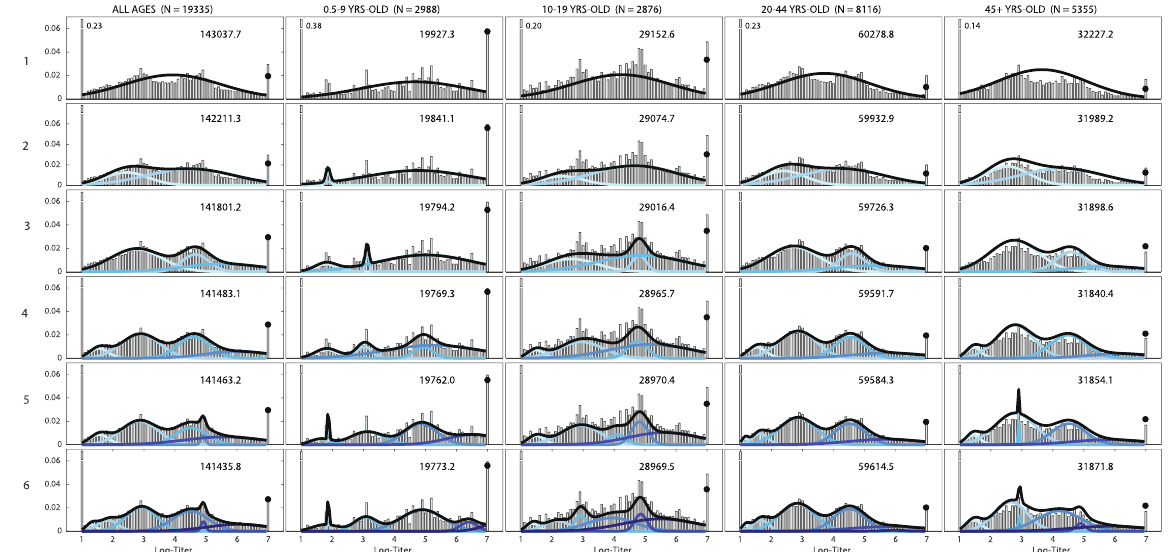
Figure 4. Titer histograms and fit results for mixture models with different numbers of components (label on the left is the number of mixture components) and grouped by different age groups recommended by the CONCISE (http://consise.tghn.org/) consortium for 2009 H1N1 influenza. Histograms are weighted to adjust for age and gender according to the Vietnam national housing census in 2009. The numbers in the upper right corner of each panel are the fitted BIC scores of the respective model. For each panel, the blue lines are the normalized probability density of the component distributions with darker colors used for increasing μ . Black lines are the total mixture distribution density; and the black dots are estimated probability weight of the mixture model for titers ≥ 7.0. The fractions of individuals with titers below the detection limit of 20 and above 1280 that were out of the plotting ranges are shown next to their respective